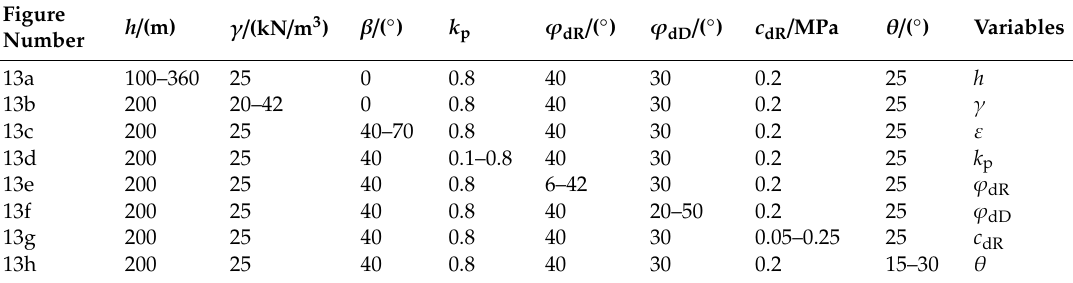
Table 2. Calculation parameters of each working condition of